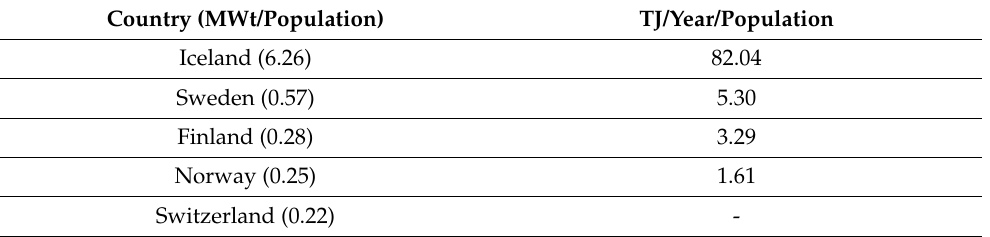
Table 3. Population-based (per 1000) ranking of the country utilizing direct geothermal energy-2015 [38].